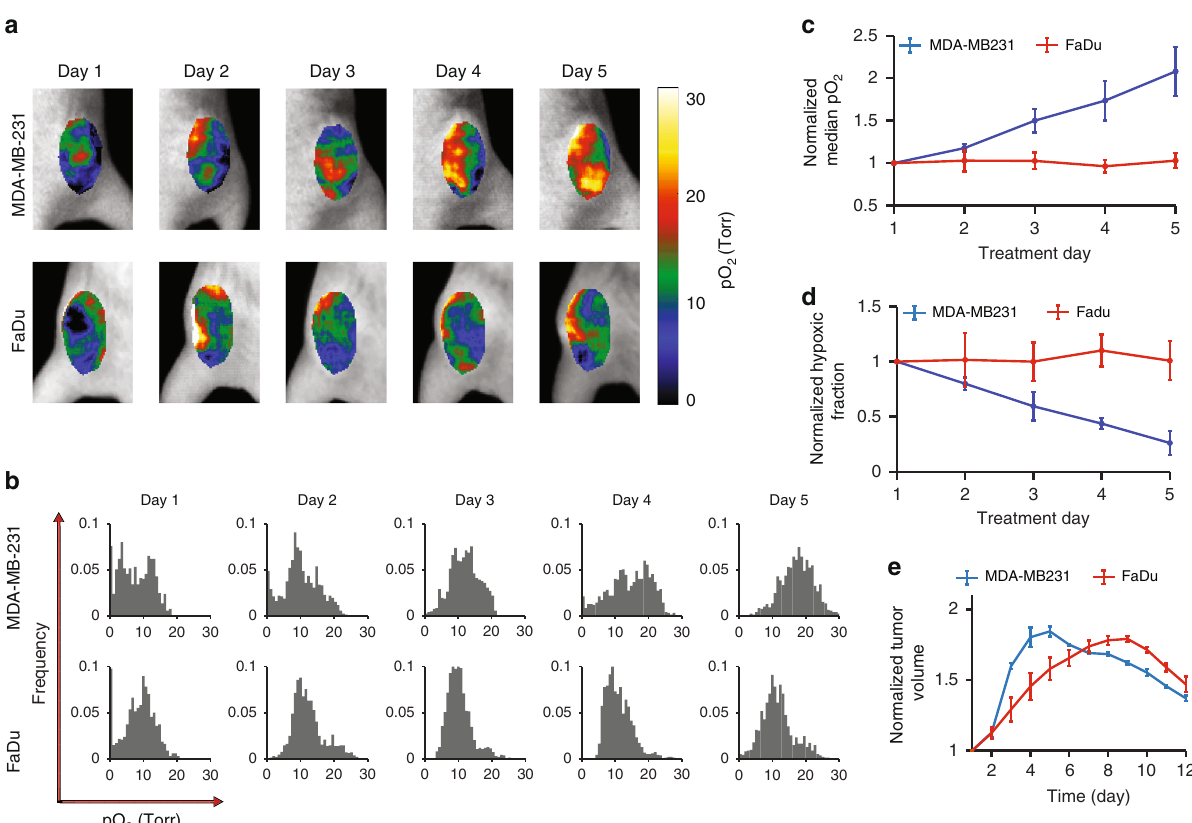
Fig. 5 In vivo longitudinal pO 2 imaging of mice with two tumor lines during 5 days-long fractionated radiotherapy. a , b Examples of pO 2 images ( a ) and of histograms ( b ) acquired during each day of the radiotherapy treatment. c , d Median pO 2 changes ( c ) and hypoxic fraction changes ( d ). Hypoxic fraction is de fi ned here as the ratio of the area with pO 2 < 10 Torr to the total tumor area. The changes in the median pO 2 ( c ) and in the hypoxic fraction ( d ) are shown relative to the respective values on the fi rst treatment day. e Relative tumor volume changes during and after the radiotherapy, normalized by the volume prior to the treatment. All data are shown as mean ± standard error of the mean ( n = 3 in c , d , e